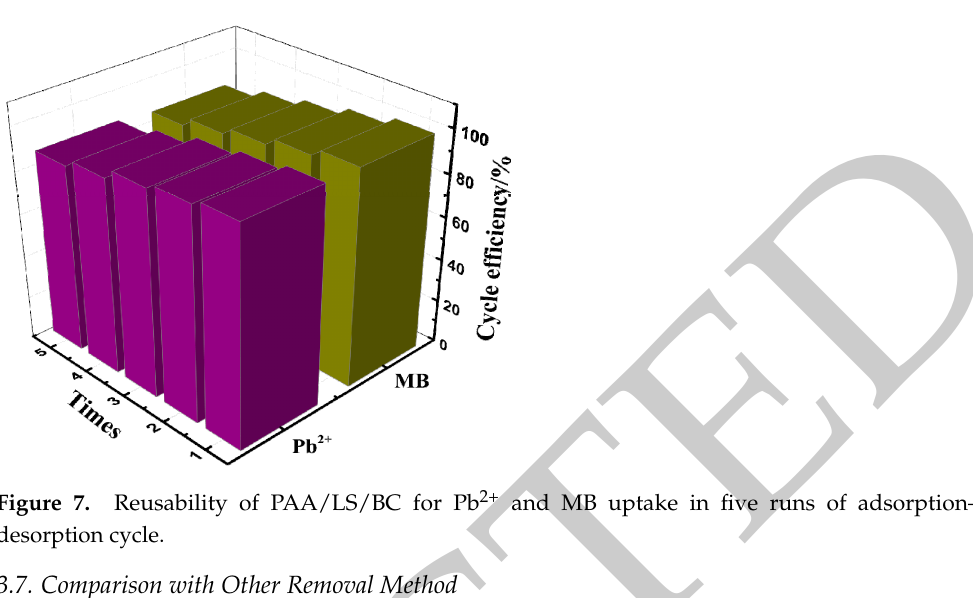
Figure 7. Reusability of PAA/LS/BC for Pb 2+ and MB uptake in five runs of adsorption–desorption cycle.